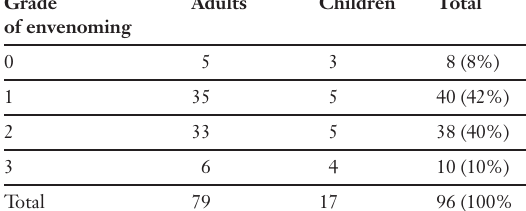
Clinical classification of 96